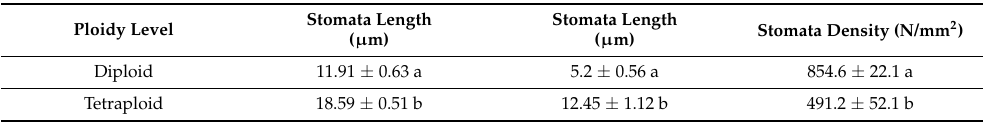
Table 2. Differences in stomatal traits of diploids and tetraploids of Vaccinium corymbosum L. var. M5. Data are presented as mean ± S.D. The means denoted by different letters are significantly different (Student’s test, p <